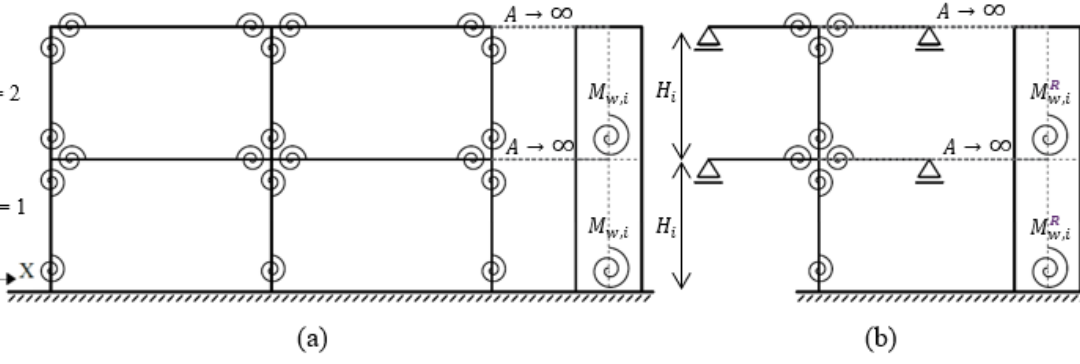
Figure 4. Schematic presentation of ( a ) MDOF model and ( b ) RDOF model of a simple wall–frame building.